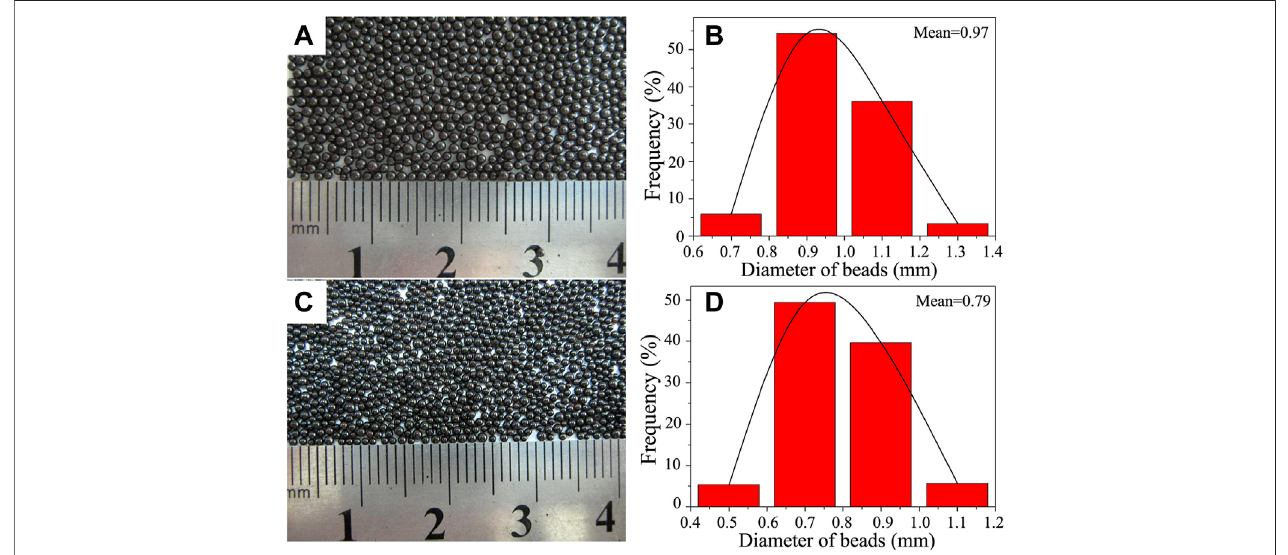
FIGURE 7 | Optical photography showing the macromorphology of PS/Fe 3 O 4 composite beads obtained with different dosages of SDBS aqueous solution: (A) 10 ml and (C) 20 ml. Panels (B) and (D) are the histograms showing the size distribution of panels (A) and (C) , respectively.